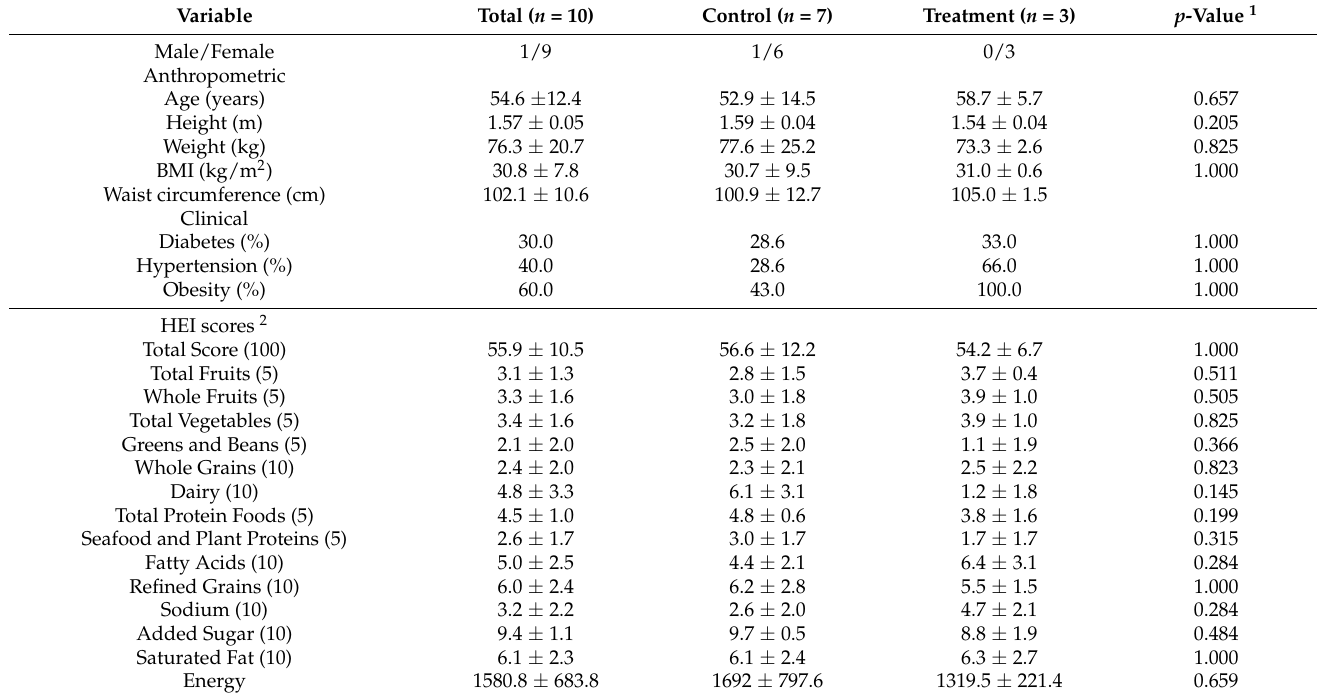
Table 1. Baseline characteristics of study participants ( n =